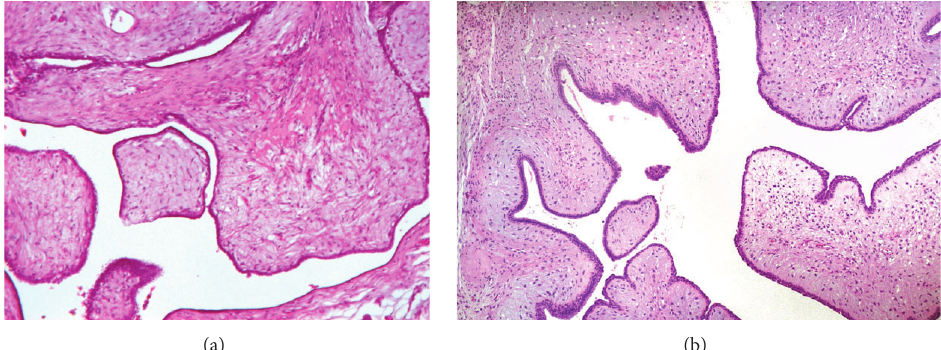
Figure 5: (a, b) H&E × 10 intracanalicular pattern forming cleft-like spaces; the stroma is mildly atypical with one mitosis per 10 high-power